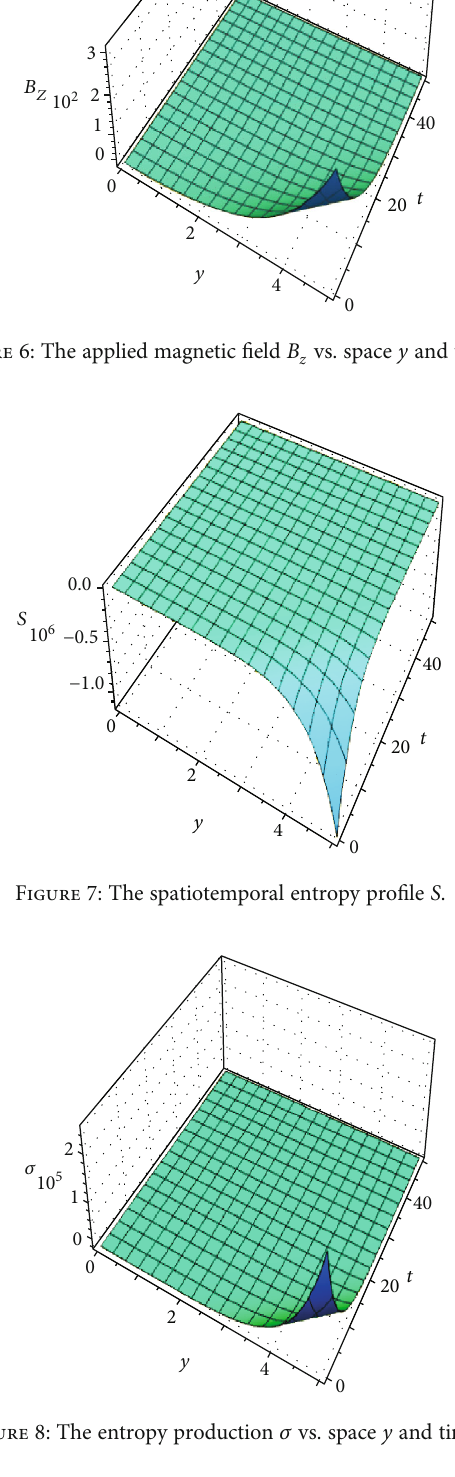
Figure 8: The entropy production σ vs. space y and time t .